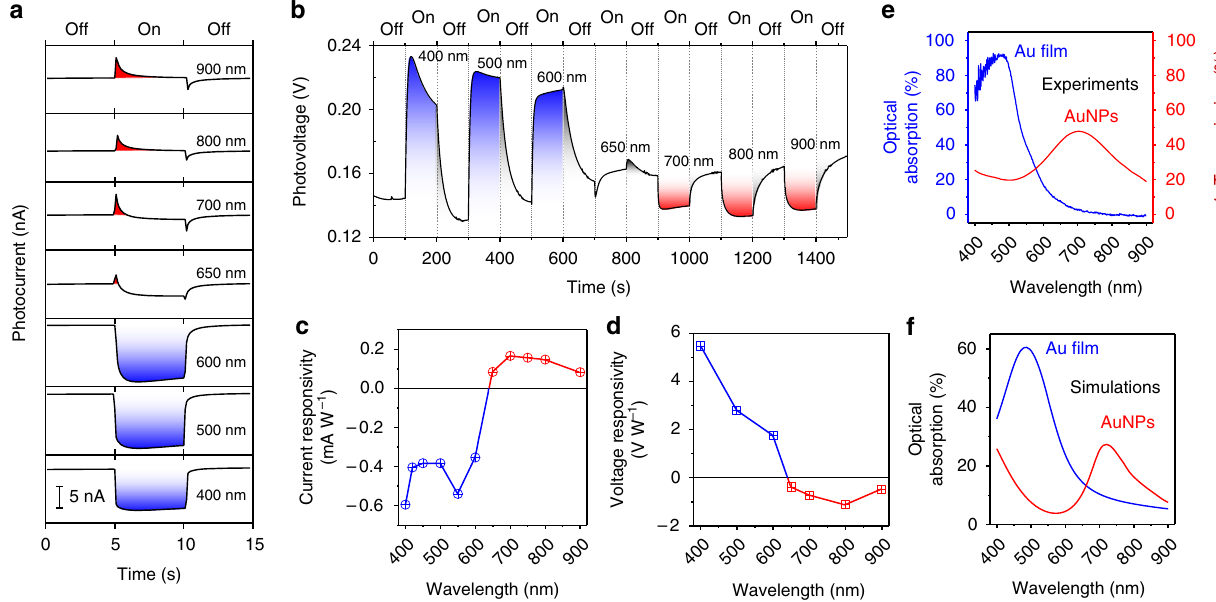
Fig. 3 Wavelength-controlled polarity-switchable photoconductivity of the dual-plasmon device. a Photocurrent in the dual-plasmon device when the illumination is turned on and off and swept in the wavelength range of 400 – 900 nm. The polarity-switching wavelength is about 650 nm. See Supplementary Movie 2 for the experimental demonstration of the wavelength-controlled polarity-switchable photoconductance. b Evolution of the photovoltage when the illumination is turned on and off and continuously swept in the wavelength range of 400 – 900 nm. c Current responsivity of the device. d Voltage responsivity of the device. e Measured optical absorption of the device in the absence of the Au fi lm ( blue ) and AuNPs ( red ). f Finite- difference time-domain (FDTD) simulations of the optical absorption of the device in the absence of the Au fi lm ( blue ) and Au nanoparticles (AuNPs) ( red